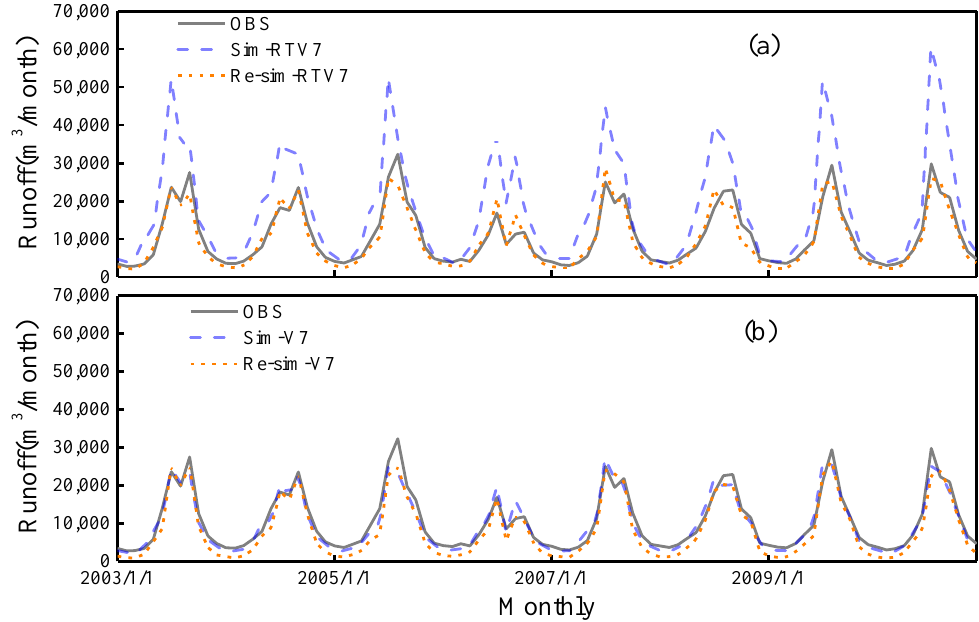
Figure 10. The VIC model driven by the upper reaches of the Yangtze River and the TMPA 3B42RTV7/V7 precipitation products used to obtain different parameters from 2003 to 2010 at monthly scales: ( a ) TMPA 3B42RTV7 simulated runoff based on the calibration parameters obtained from the gauged precipitation and TMPA 3B42RTV7; ( b ) TMPA 3B42V7 simulated runoff based on the calibration parameters obtained from the gauged precipitation and TMPA 3B42V7. Table 4. The statistical summary of the simulated runoff driven by TMPA 3B42TRV7/V7 using different hydrological parameters in the upper Yangtze reaches (relative bias (RB), correlation coefficient (CC) and the Nash–Sutcliffe coefficient of efficiency (NSCE)).